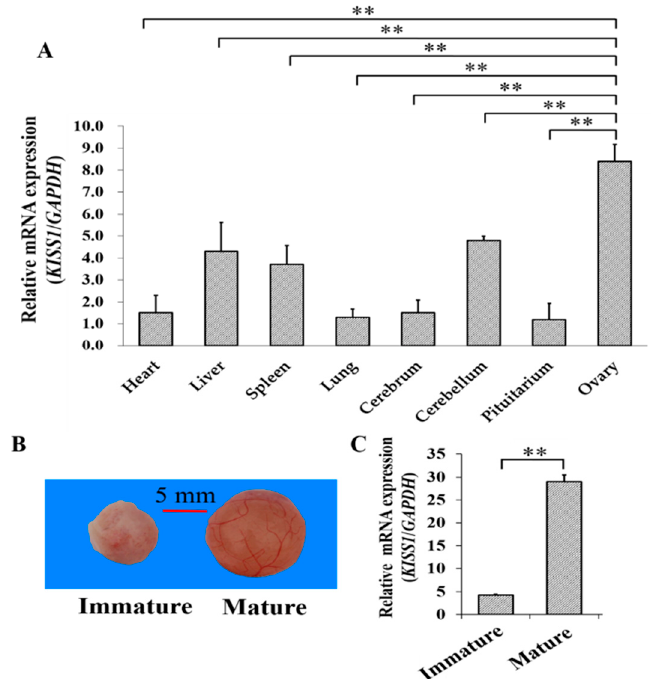
Figure 1. Relative mRNA Expression of KISS1 during follicular maturation in pigs. ( A ) Tissue expression profile of KISS1 mRNA in gilts with the first standing reflex. ( B ) Representation of immature to mature follicles. ( C ) Changes of KISS1 mRNA expression from immature to mature follicles. ** indicates p < 0.01.